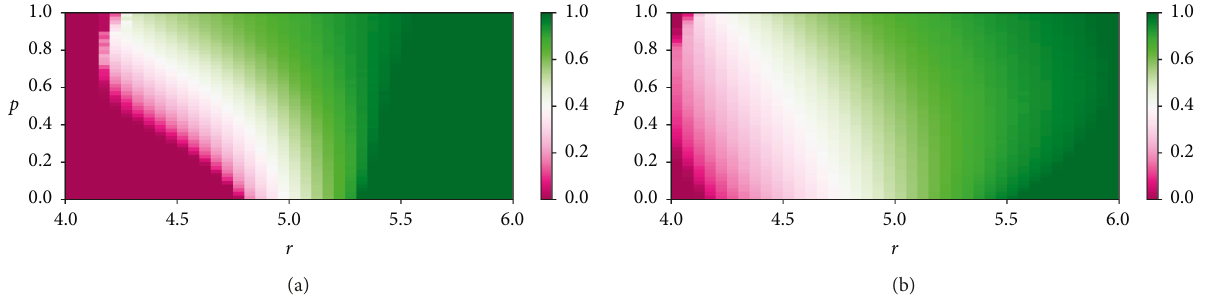
Figure 6: The cooperative level ρ versus the parameter space ( p , r ) for random networks (top panel) and WS small-world networks with a C rewiring probability 0.1 (bottom panel), respectively.